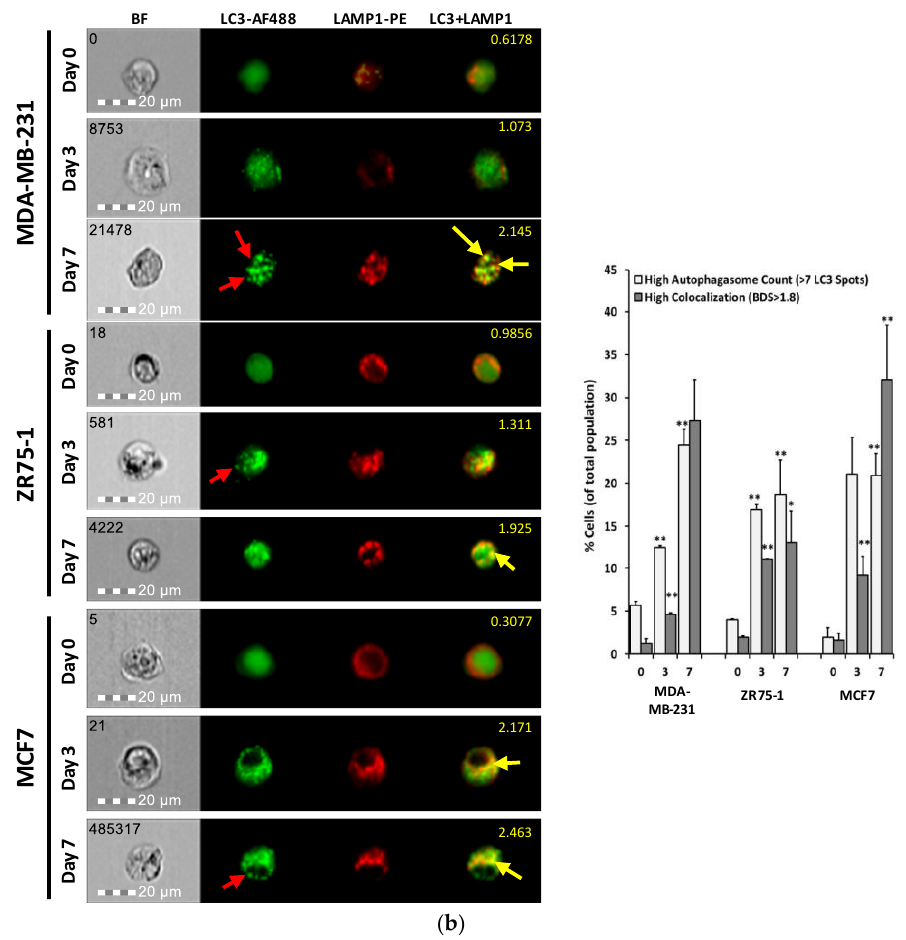
Figure 3. Non-adherent cultured cells increased the autophagic flux as measured by the LC3 I-II turnover and autolysosomal formation. ( a ) Western blot analysis of the BCC lines, cultured in monolayer or suspension condition up to seven days. Cell lysates were analyzed for LC3-I (top band) and LC3-II (bottom band), p62, and GAPDH. LC3-II to LC3-I relative protein ratio indicating the LC3 turnover compared to the monolayer (day 0) (mean ± SEM; n = 3; * p < 0.05). Relative expression of the p62 to the monolayer-cultured cells (mean ± SEM; n = 3; * p < 0.05). ( b ) Images of the MDA-MB-231, ZR75-1 and the MCF7 cells cultured in monolayer (day 0) or suspension for three or seven days, captured using imaging flow cytometry. Figure shows brightfield (BF), LC3-AF488 (green), LAMP1-PE (red), and a composite image of the co-localization of LC3 and LAMP1 (yellow). Autophagosomes are indicated with red arrows and the co-localization of LC3 and LAMP1, representing the autolysosome formation, is shown with yellow arrows. Corresponding bright detail similarity score between the LC3-AF488 and the LAMP1-PE puncta is shown in yellow. (Single fluorophore controls are provided in Figure S4). Population analysis of cells undergoing autophagy (high autophagosome counts ( ≥ 7 LC3+ spots per cell)) and autophagic flux (high co-localization of LC3-AF488 and LAMP1-PE (bright detail similarity score ≥ 1.8)) (mean ± SEM; n = 3; * p < 0.05, ** p < 0.01 relative to